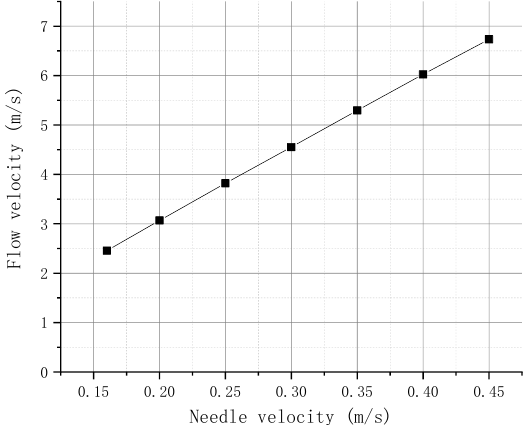
Figure 6. Flow velocity in different needle velocities.